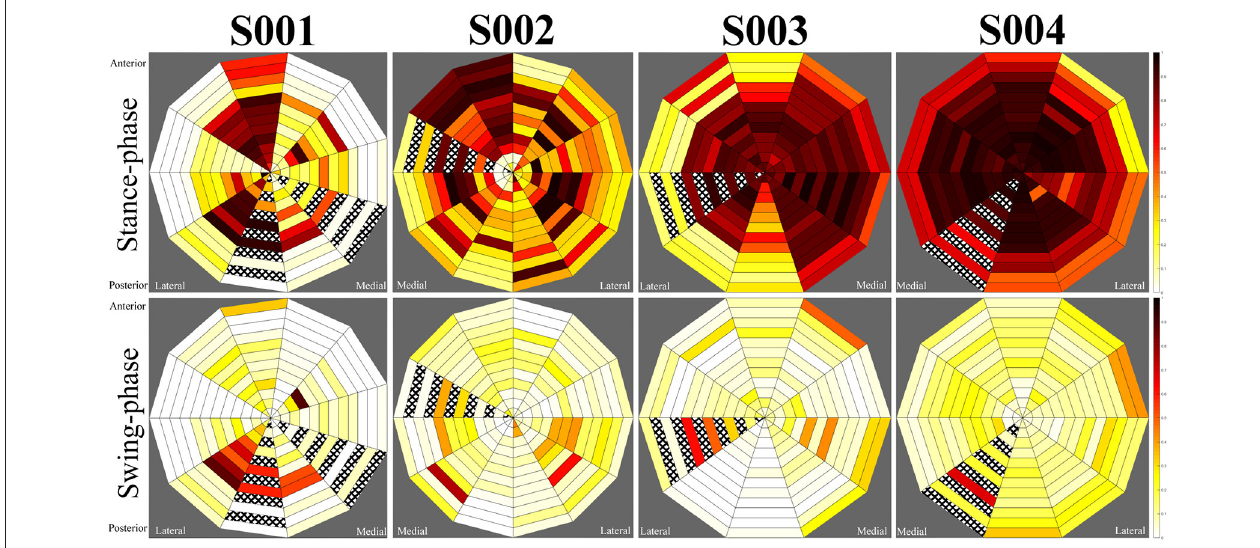
FIGURE 6 | Average turning step pressure maps for each subject. Top row: stance phase, bottom row: swing-phase.